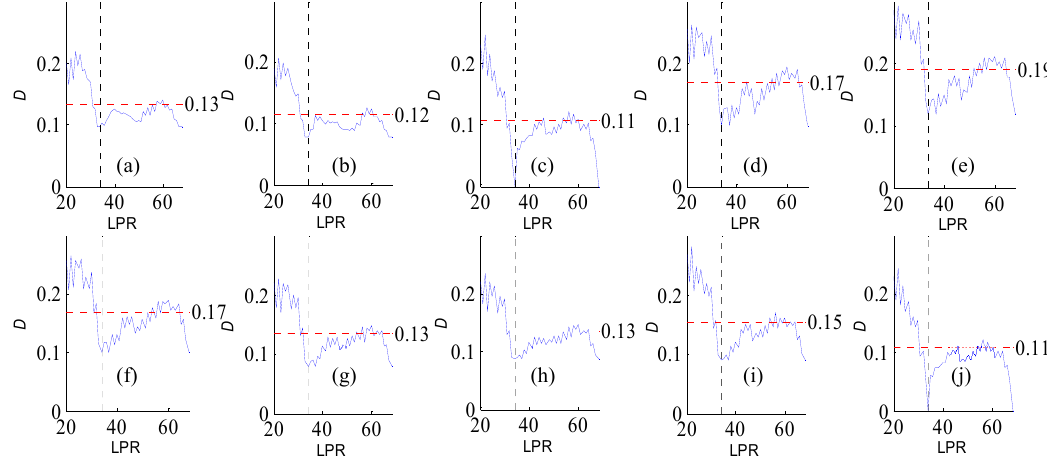
Figure A20. Variation of flow regime alteration degree (D) measured by the RVA with change in the length of post-impact flow time series (LPR) under a periodicity of 34 years. ( a ), ( b ), ( c ), ( d ), ( e ), ( f ), ( g ), ( h ), ( i ), and ( j ) correspond to pre-impact flow time series length = 24, 29, 34, 39, 44, 49, 53, 58, 63, and 68 years, respectively. The abscissa value for the vertical dotted line is 34. The ordinate value for the horizontal dotted line is the mean degree of flow regime alteration in each subfigure.